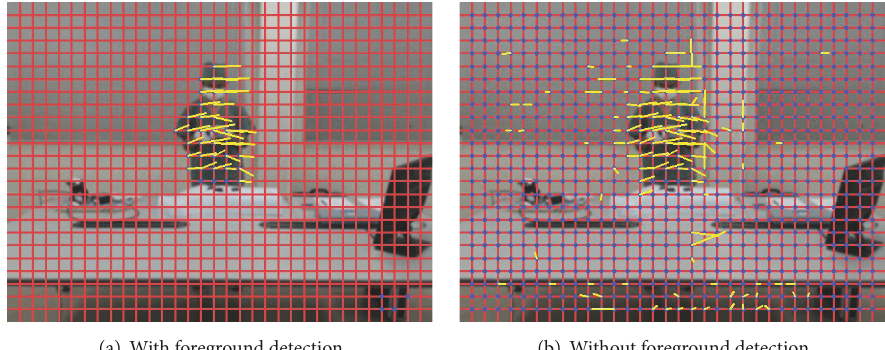
Figure 2: An example of extracted OFs with or without foreground detection.